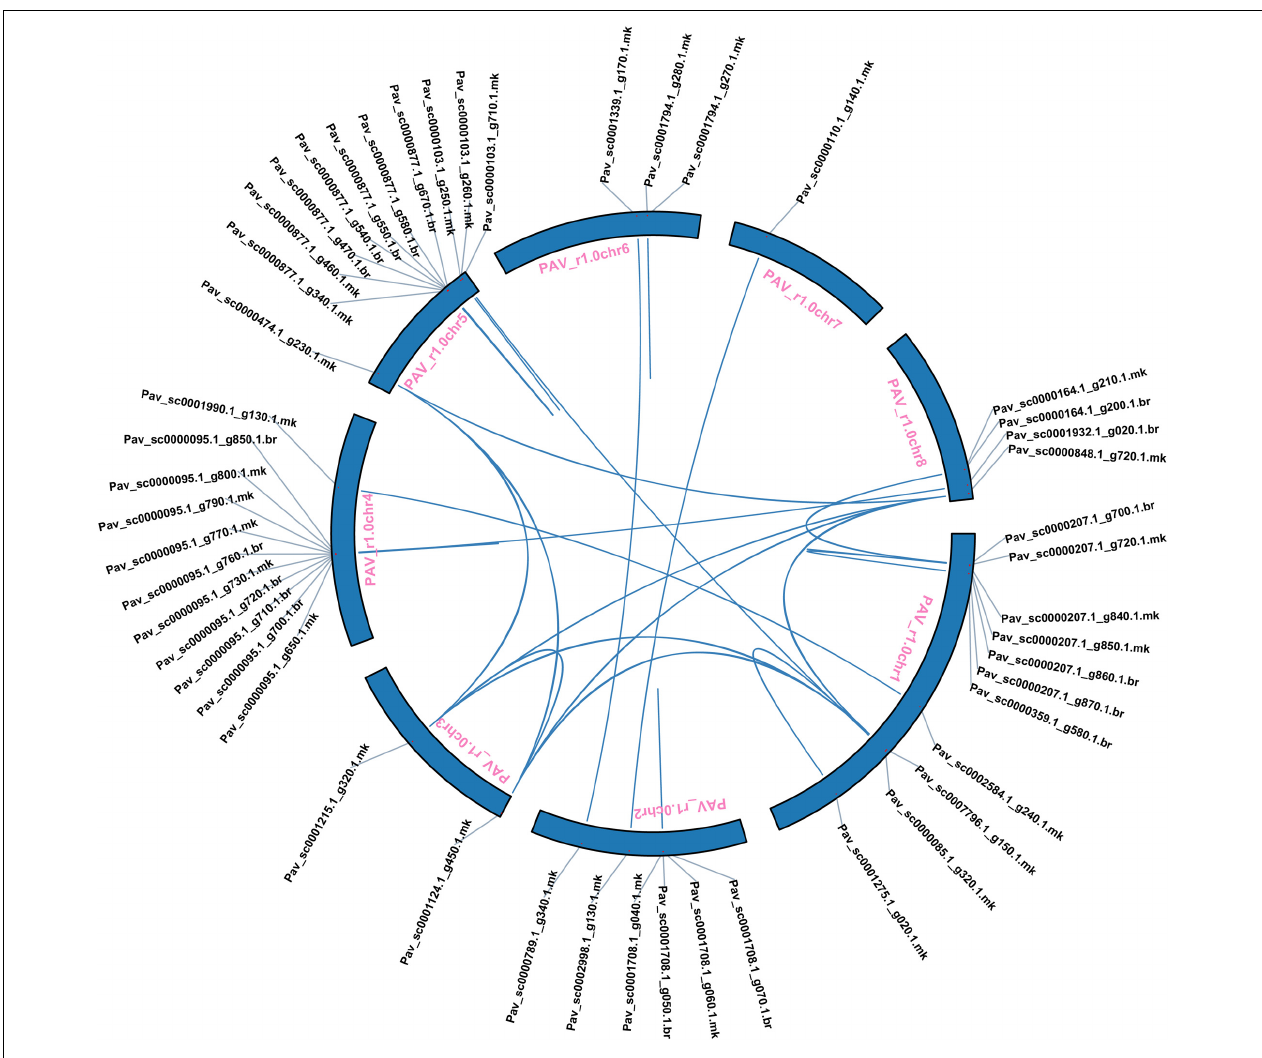
FIGURE 4 | Prunus avium have chromosomal localization and mode of gene duplication. A colorful line links duplicated gene